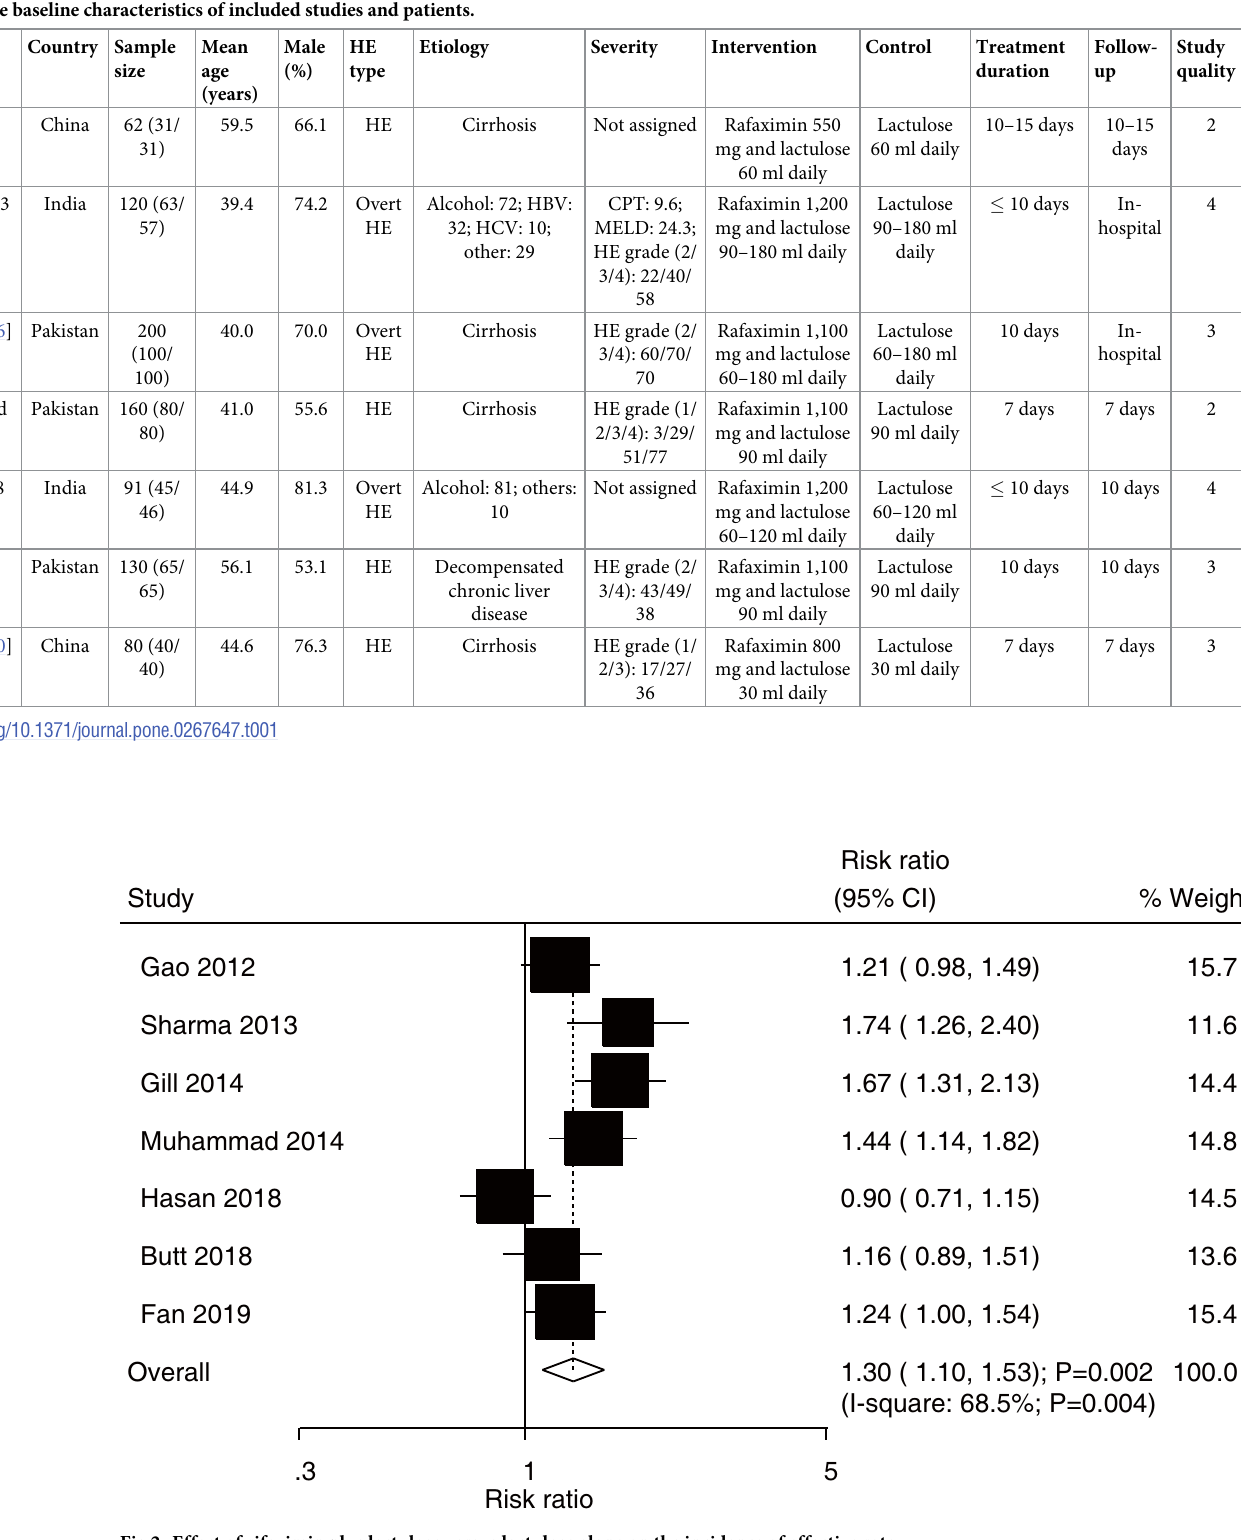
Fig 2. Effect of rifaximin plus lactulose versus lactulose alone on the incidence of effective rate.